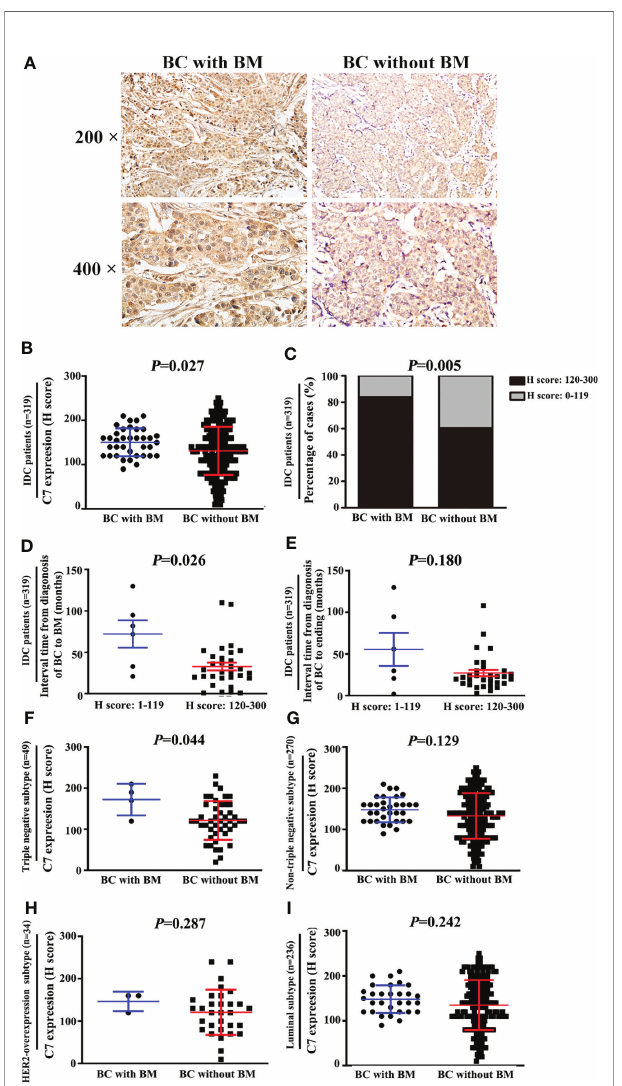
FIGURE 4 | High expression of C7 promoted triple negative subtype patients developing bone metastasis (BM). (A) Representative images of C7 expression in primary tumor specimens from breast cancer patients with BM and patients without BM, respectively (magni fi cation 200× and 400×). (B) C7 expression score in IDC patients who developed BM was higher than those without BM ( P = 0.027). (C) Percentage of high C7 expression in patients who developed BM was higher than those without BM ( P =0.005). (D) IDC patients with high expression of C7 exhibited earlier occurrence of BM. The median interval time from the diagnosis of breast cancer (BC) to BM in patients with high C7 expression was shorter than the low C7 expression group ( P = 0.026). (F) In the triple negative subtype, C7 expression in patients with BM was much higher than that in those without BM ( P = 0.004). (G, H) In the non-triple negative subtype (F, G) , HER2-overexpression subtype (F) and luminal B subtype (G) , no statistical difference of C7 expression was found between patients with BM and those without BM. (I) In luminal subtype, C7 expression in patients with BM was much higher than that in those without BM ( P = 0.004).